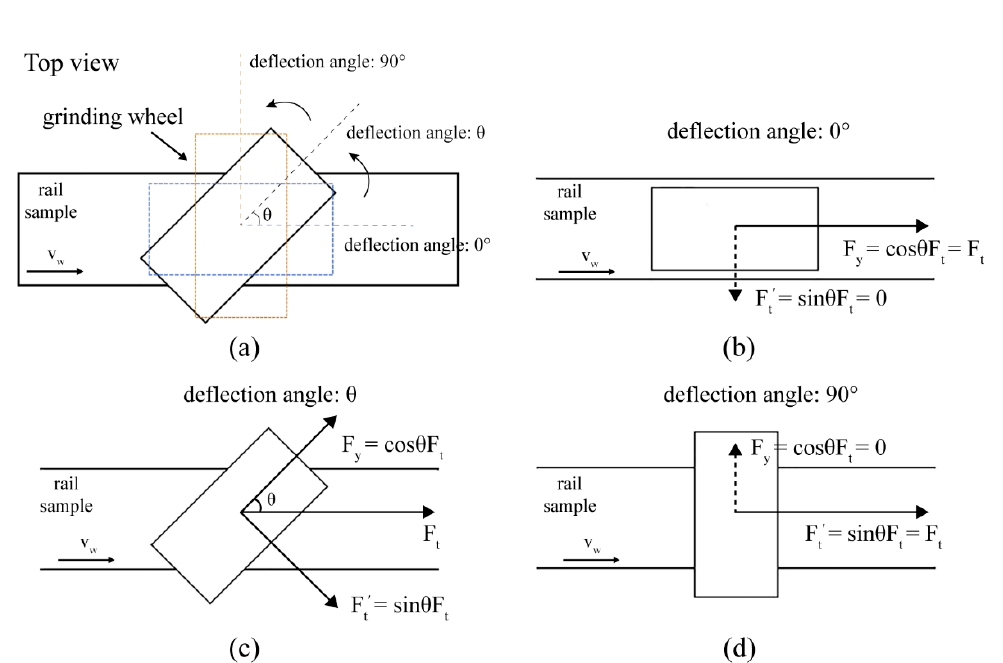
Figure 8. Top view of force analysis of passive grinding wheel under different deflection angles, ( a ) range of deflection angle, ( b ) deflection angle is 0°, ( c ) deflection angle is θ , ( d ) deflection angle is 90°.